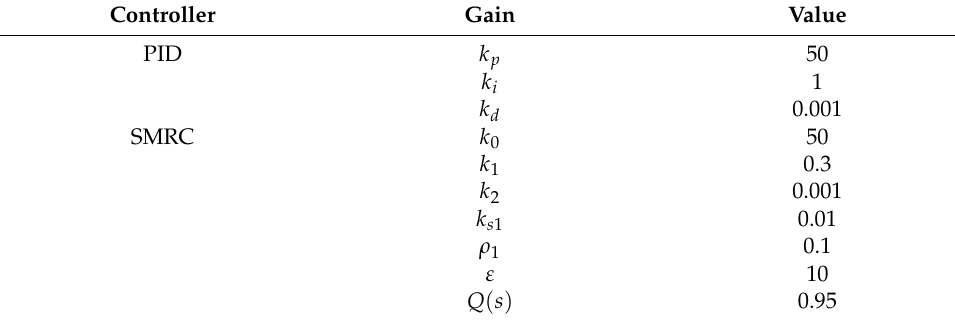
Table 6. Main parameters of controllers in the hip joint.